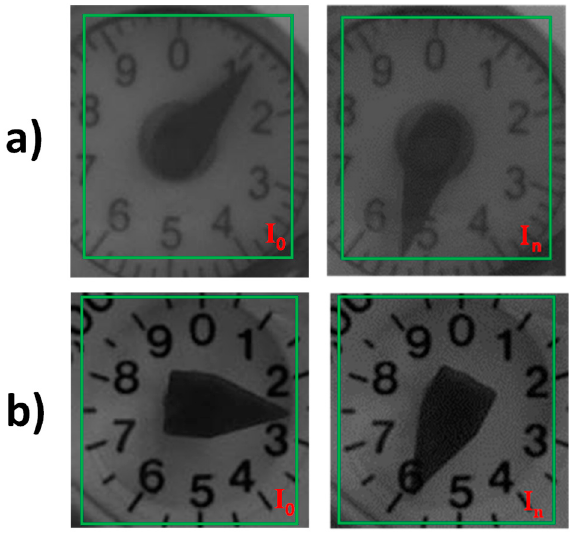
Figure 2. Acquired pictures on both water meters. In ( a ) the volumetric, in ( b ) the multijet; green boxes indicate the ROI where the cross-correlation is evaluated.